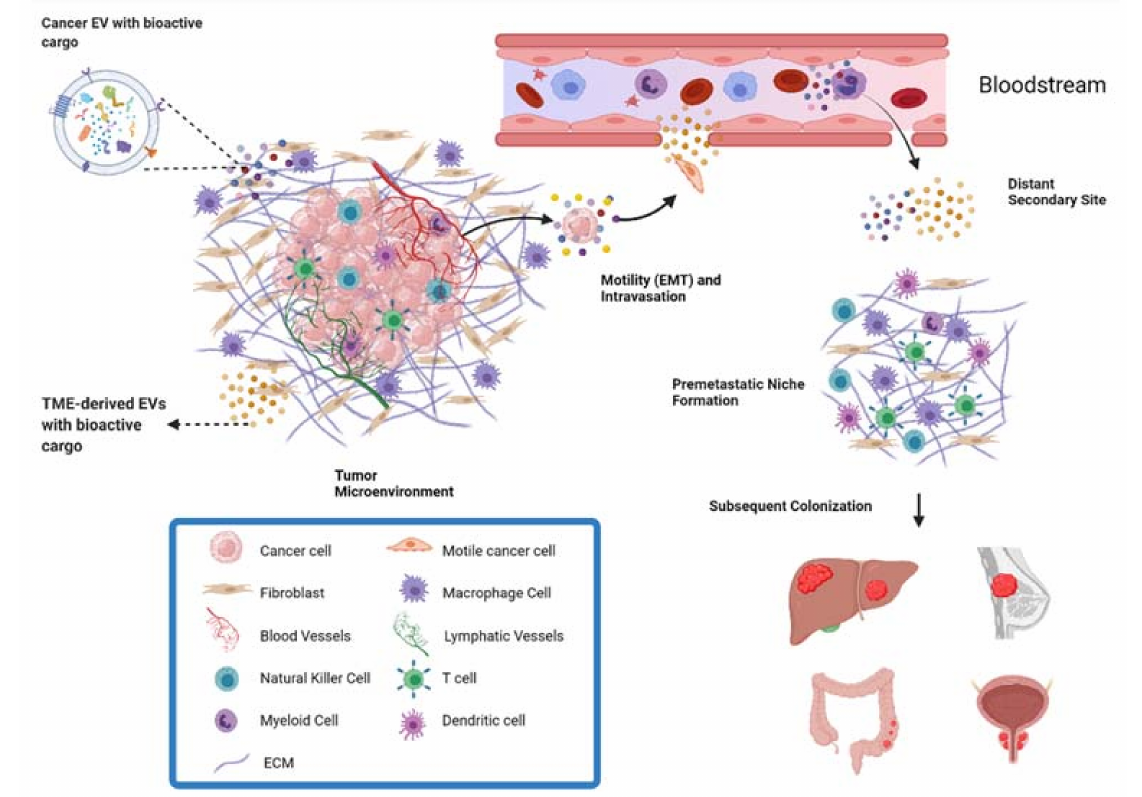
Figure 1. Overview of metastasis and contribution of EVs. EVs derived from both cancer cells and the cells of the TME can facilitate metastasis. EVs can act on surrounding cells in the TME to exert pro-metastatic effects, or act in an endocrine manner through the bloodstream. For example, EVs from cells of the TME can increase the motility and invasive capacity of cancer cells, allowing them to invade local tissue and intravasate into the bloodstream for transport to distant parts of the body. Through the endocrine pathway, EVs also play a role in preparing the premetastatic niche in a distant secondary site to be a supportive environment for metastatic cancer